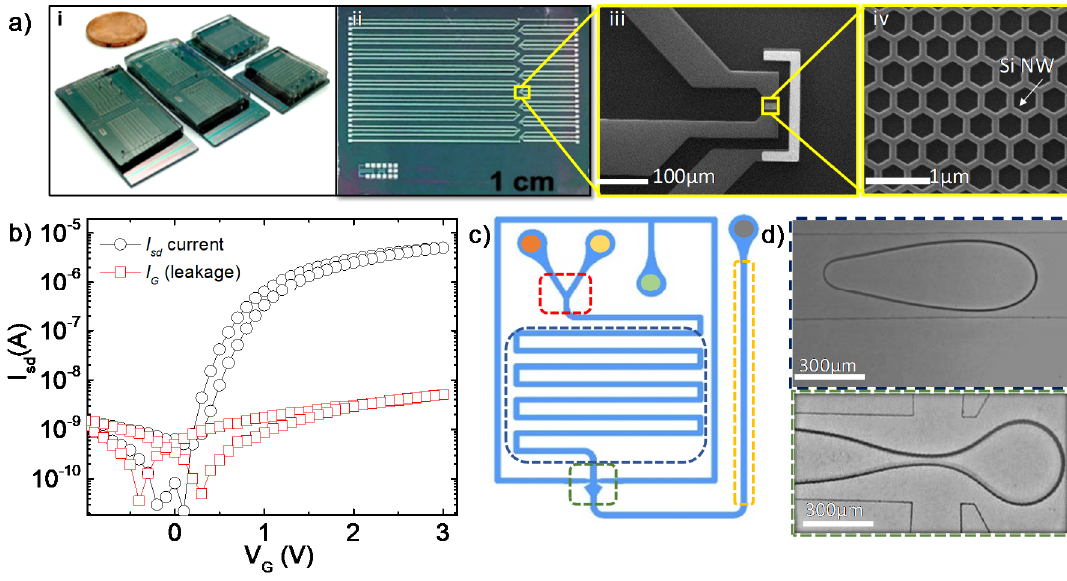
Figure 2. FET sensors with microfluidic integration. ( a ) Ready to use devices where a polydimethylsiloxane (PDMS) flow cell is permanently attached to the FET chip with the microfluidic channel aligned directly over the array of FETs: ( i ) FET chip with 16 devices ( ii ), SEM magnification of a single FET with Ag / AgCl-modified gate electrode ( iii ), and Si honeycomb structure ( iv ). ( b ) Transfer characteristics of a single FET device (@V sd = 0.1 V). ( c ) Design of the microfluidic cell: two inlets for reactants (orange and yellow circles), inlet for oil (green circle), and outlet (gray circle). Reactants mix in the red area and the mixture is incubated while passing the channel (blue area). Droplets are generated (green area, magnified below) and guided to the sensors (yellow area). ( d ) Images of the channel (top) and droplet generating structure